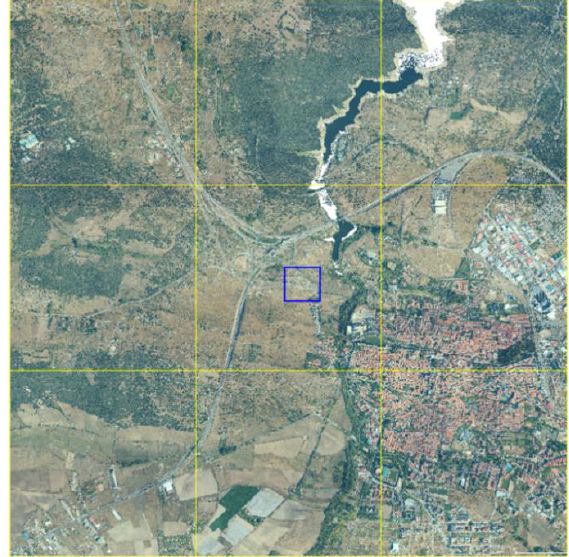
Figure 3. Driver's vision field: a) horizontal plane, b) vertical plane, c) analysis in the horizontal vision field d) analysis in the vertical vision field